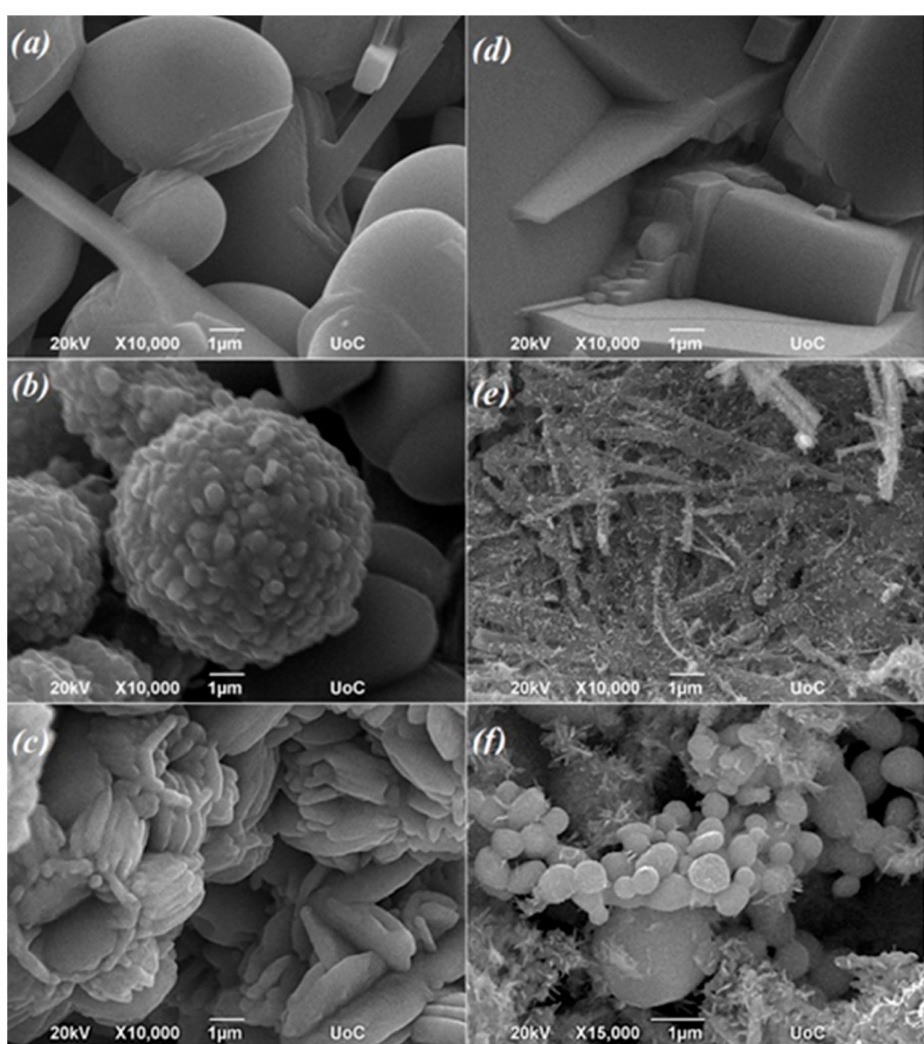
Figure 2. Scanning electron microscopy images of the ‘final’ synthesized materials using oxalic acid—without additives ( a ), oxalic acid—urea ( b ), oxalic acid—thiourea ( c ), succinic acid—without additives ( d ), succinic acid—urea ( e ), and succinic acid—thiourea ( f